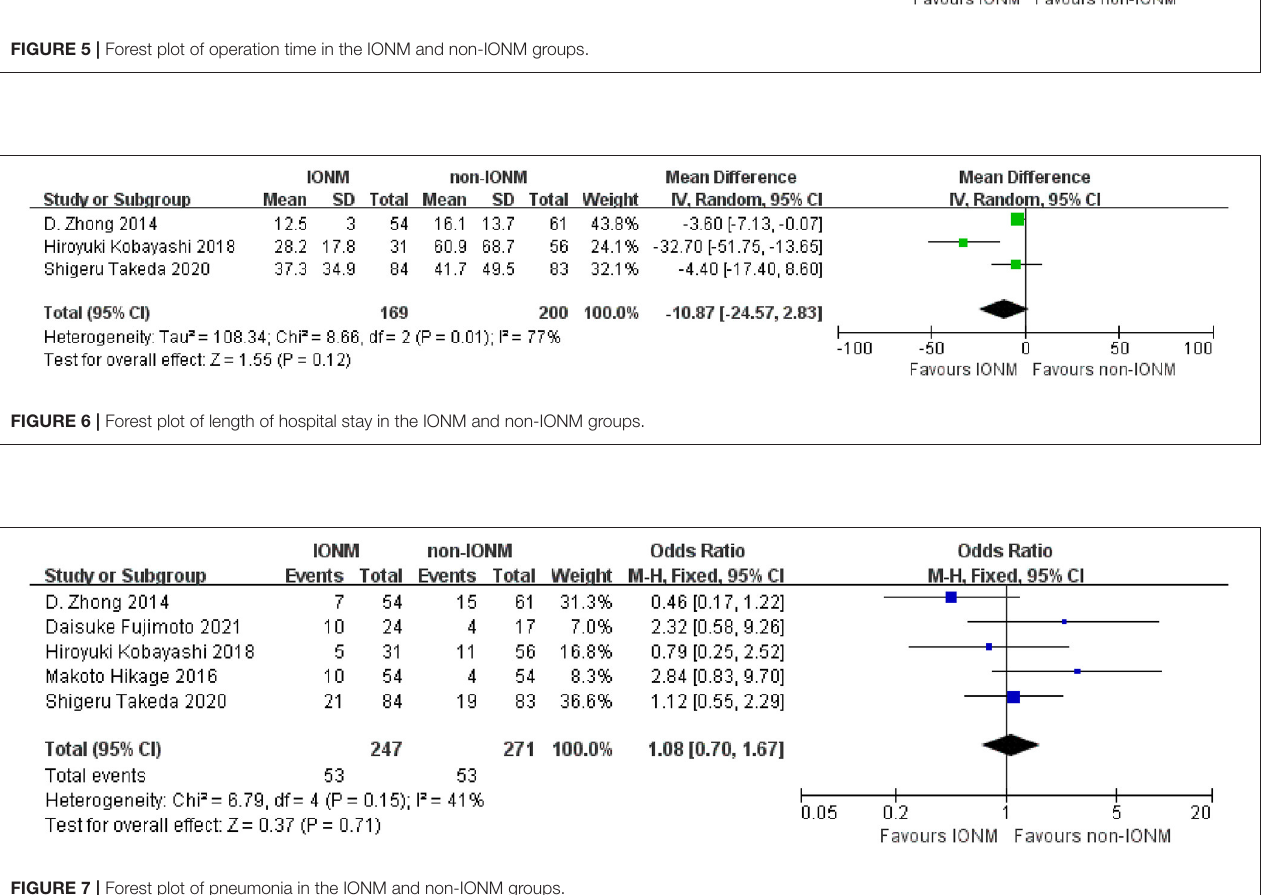
Frontiers in Surgery |